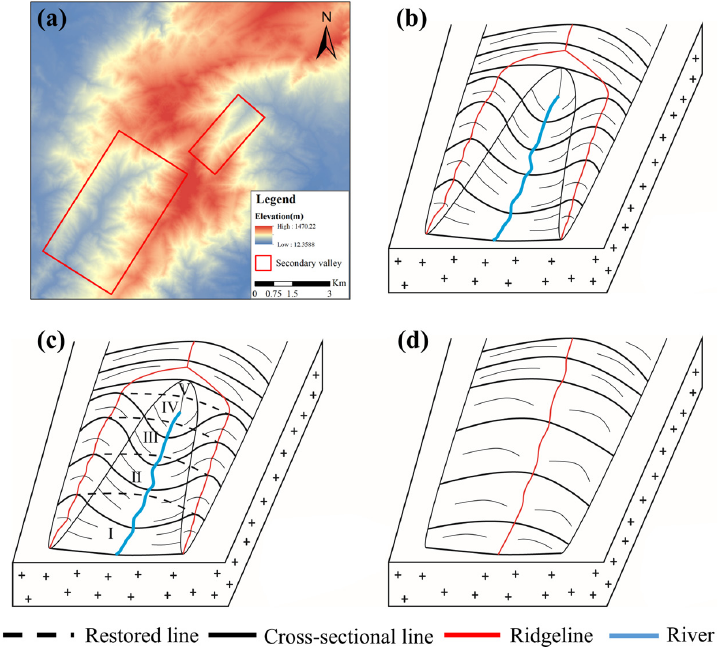
Figure 18. An example of a secondary valley on the anticline’s summit. ( a ) The secondary valley on Lushan Mountain in Jiangxi Province; ( b ) the simulation model of the secondary valley; ( c ) fitting the missing portion of each cross-sectional line and splitting many subareas; and ( d ) the secondary valley’s paleotopography.